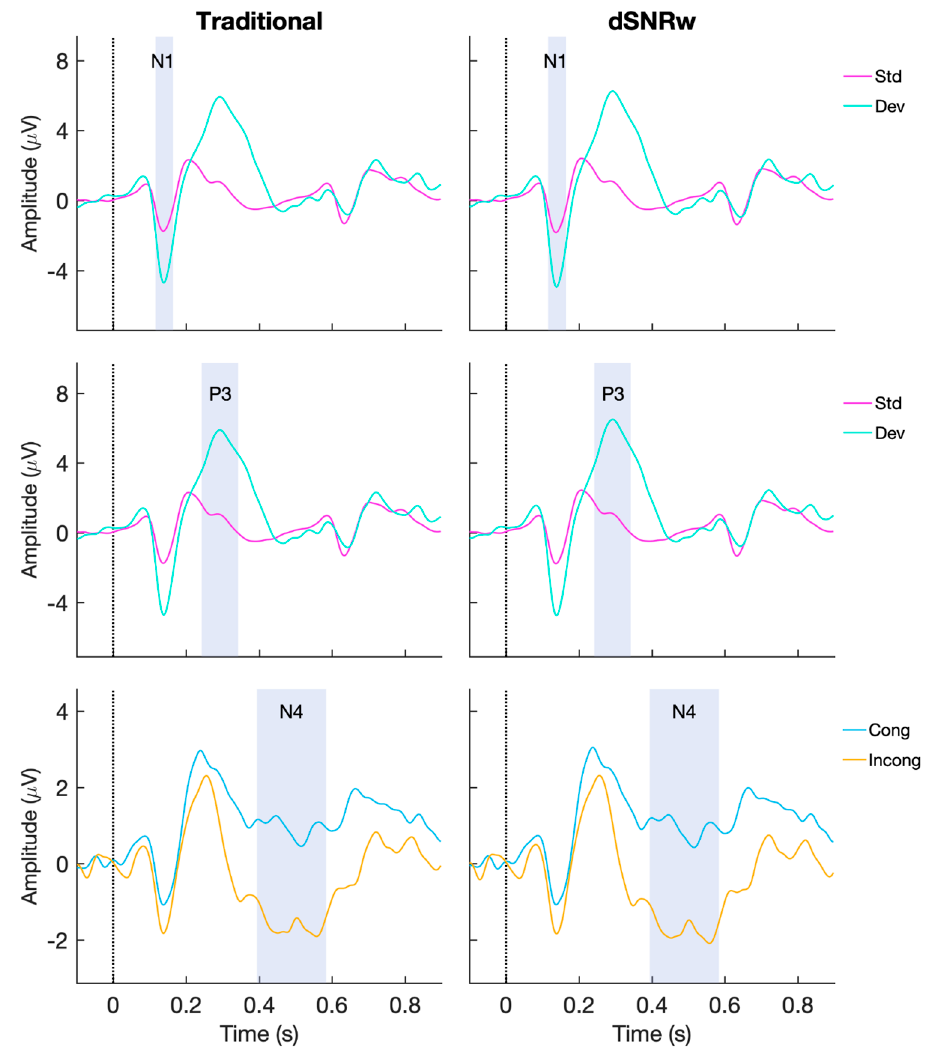
Figure 5. Group averaged ERP waveforms. ( Left ): ERP responses corresponding to N100 (N1), P300 (P3) and N400 (N4) derived from traditional channel pooling. ( Right ): ERP responses derived using dSNRw channel pooling. Shaded sections correspond to time windows of interest for respective ERP components. Std = standard tonal stimuli, Dev = deviant tonal stimuli, Cong = congruent word stimuli, Incong = incongruent word stimuli.